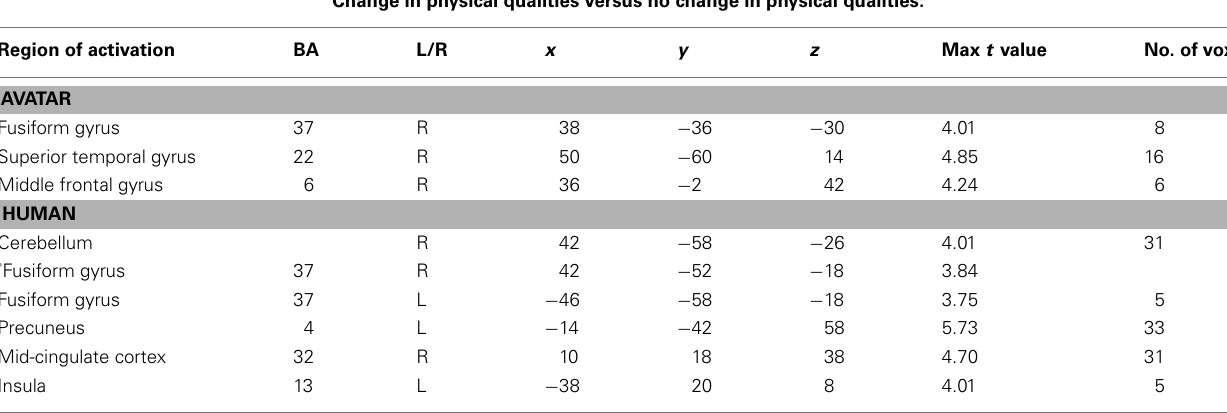
Table 1 | Brain areas sensitive to physical change.